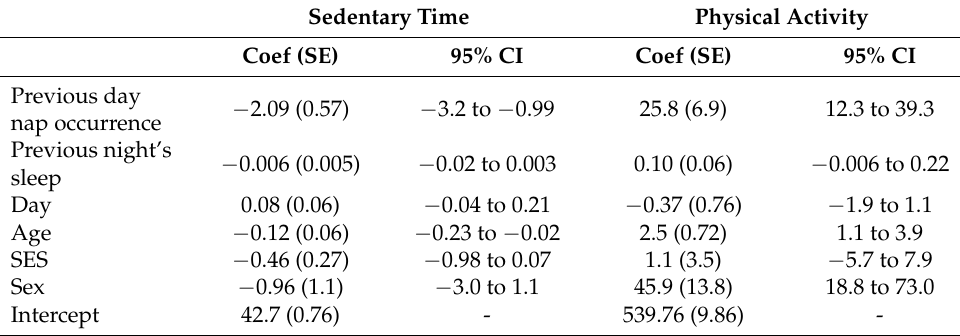
Table 4. Multilevel linear regression results for movement